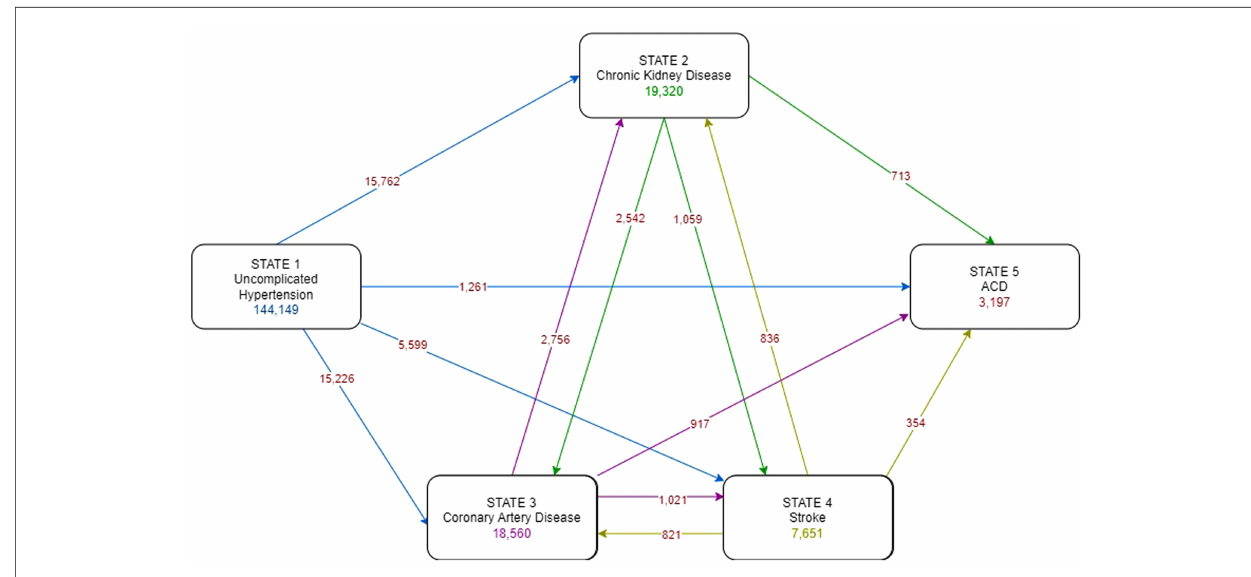
FIGURE 2 Multi-state diagram of progression of